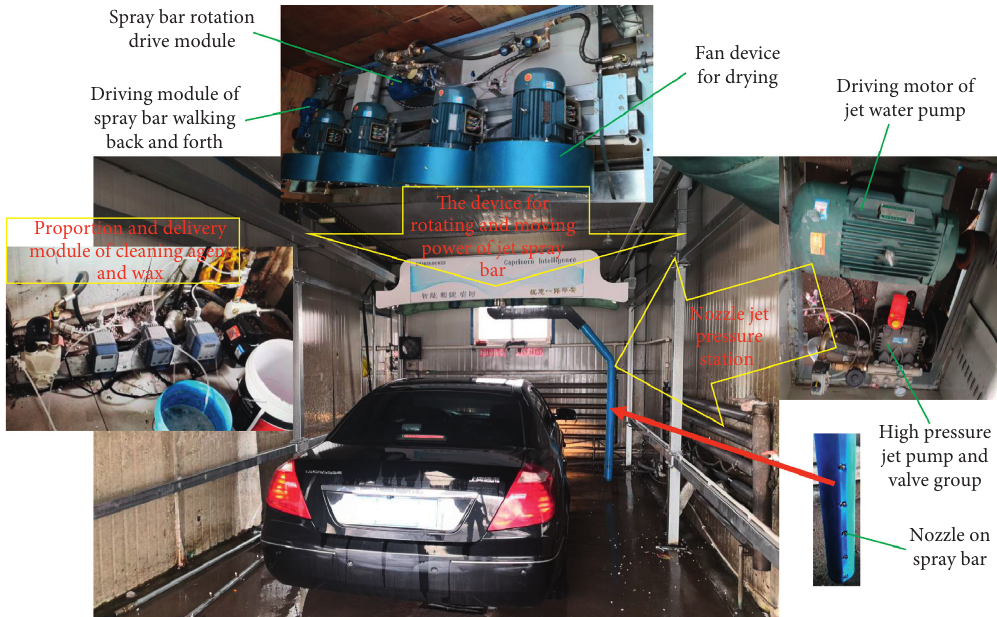
Figure 19: Layout of on-site automatic automobile washer.